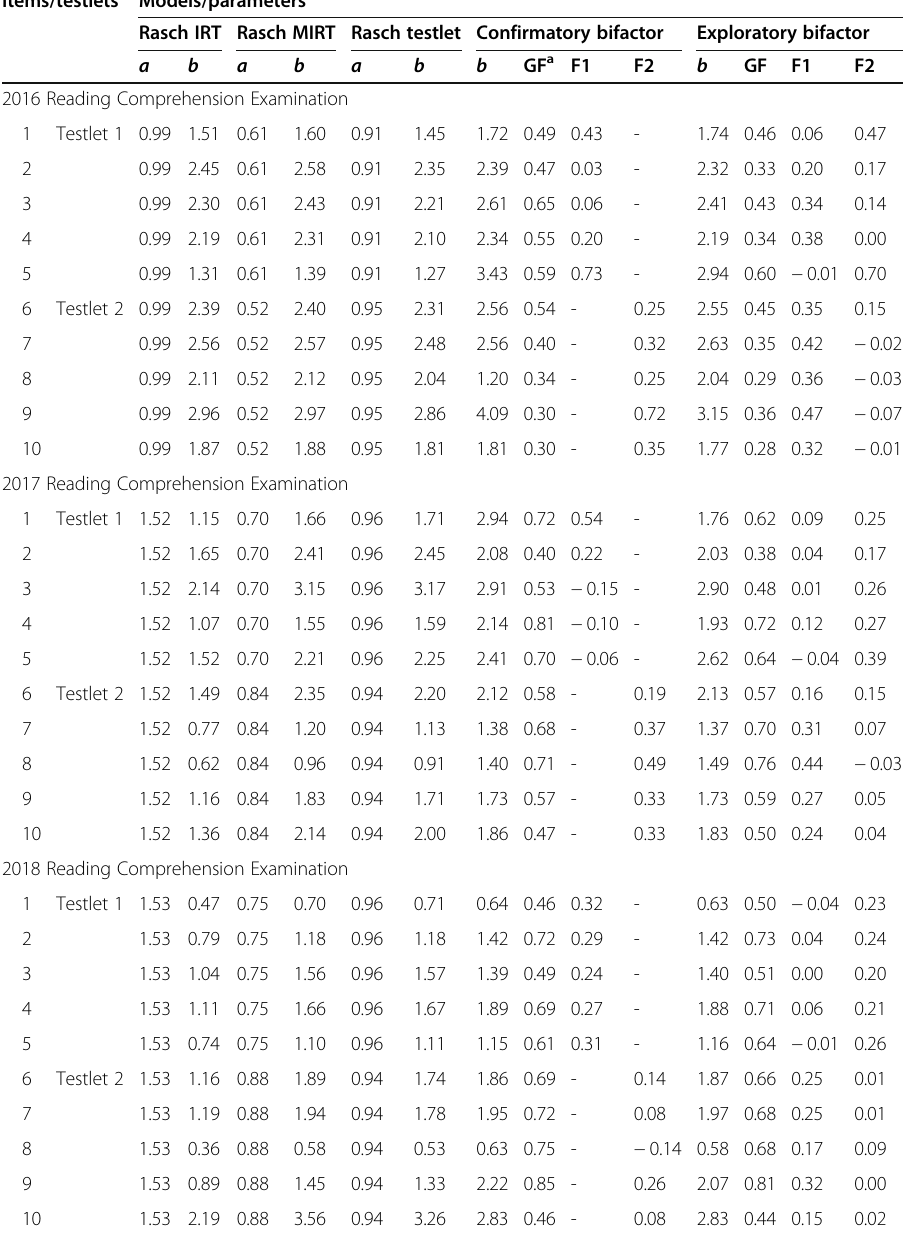
Table 3 Item difficulty and discrimination parameters under different Rasch and bifactor models Items/testlets Models/parameters Rasch IRT Rasch MIRT Rasch testlet Confirmatory bifactor Exploratory